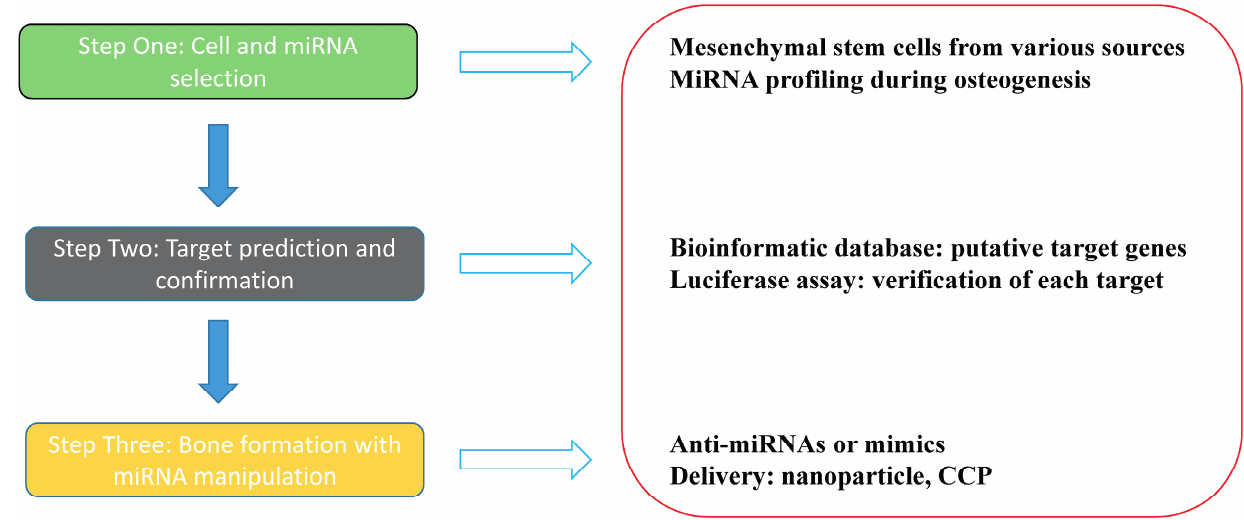
Figure 1. MiRNA-based skeletal